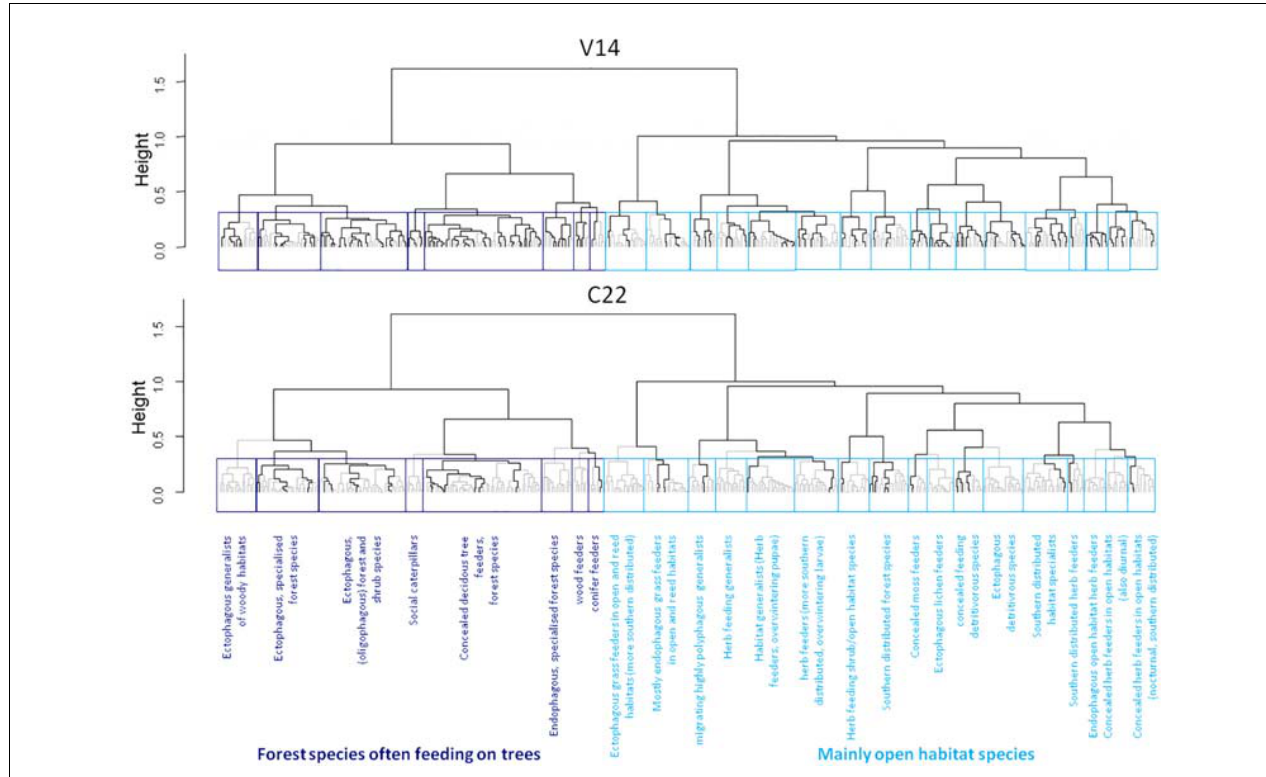
FIGURE 2 | Functional dendrogram of the whole observed moth species pool (387 species) in the two pine forest reserves in NE Italy. The two most extreme local moth communities are depicted exemplarily. Upper panel: a species-rich ‘high quality’ plot (V14) with multiple species represented in most functional groups. Lower panel: a species poor plot (C22) with few or even no species representing most functional groups. Species present at each site are indicated by black lines. Statistically significant sub-clusters after a PERMANOVA (accepted as functional groups in this study) are shown as blue boxes. Different colors indicate the two main sections of species that generally partition the functional dendrogram into moths of woodland (dark blue) and open habitats (light blue),